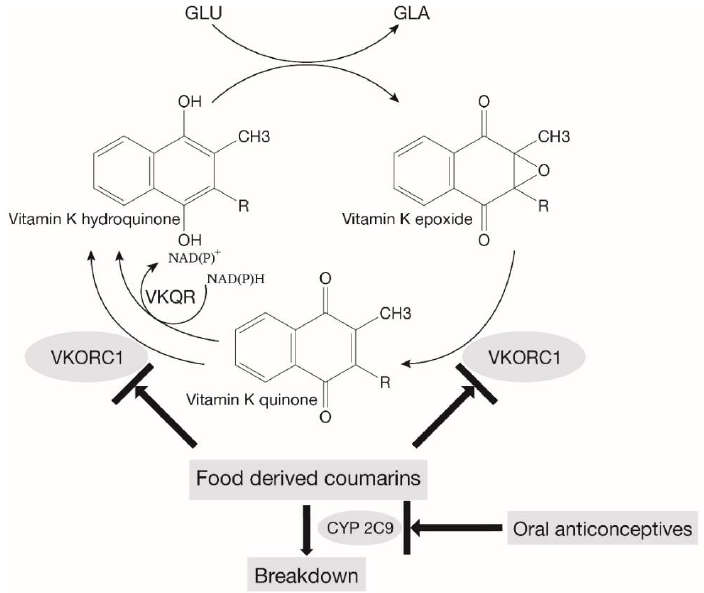
Figure 2. Vitamin K cycle with influences. The role of vitamin K epoxide reductase (VKORC1) and the cytochrome P450 iso-enzyme 2C9 (CYP2C9) in coagulation: VKORC1, as well as the vitamin K quinone reductase (VKQR), is involved in reducing steps in the generation of the active hydroquinone form of vitamin K. Inhibition or diminished activity of CYP2C9 leads to a decreased breakdown and subsequent excretion of food-derived VKORC1-inhibiting coumarins. Presence of polymorphisms and inhibition of VKORC1 reduces vitamin K activity, viz. carboxylation of glutamic acid (GLU) into calcium-binding gamma-glutamic acid residues (GLA). In addition, polymorphisms and inhibition of CYP2C9 by oral contraceptives or antifungal agents might decrease the breakdown of VKORC1 inhibiting compounds. Decreased VKORC1 activity has been associated with the occurrence of